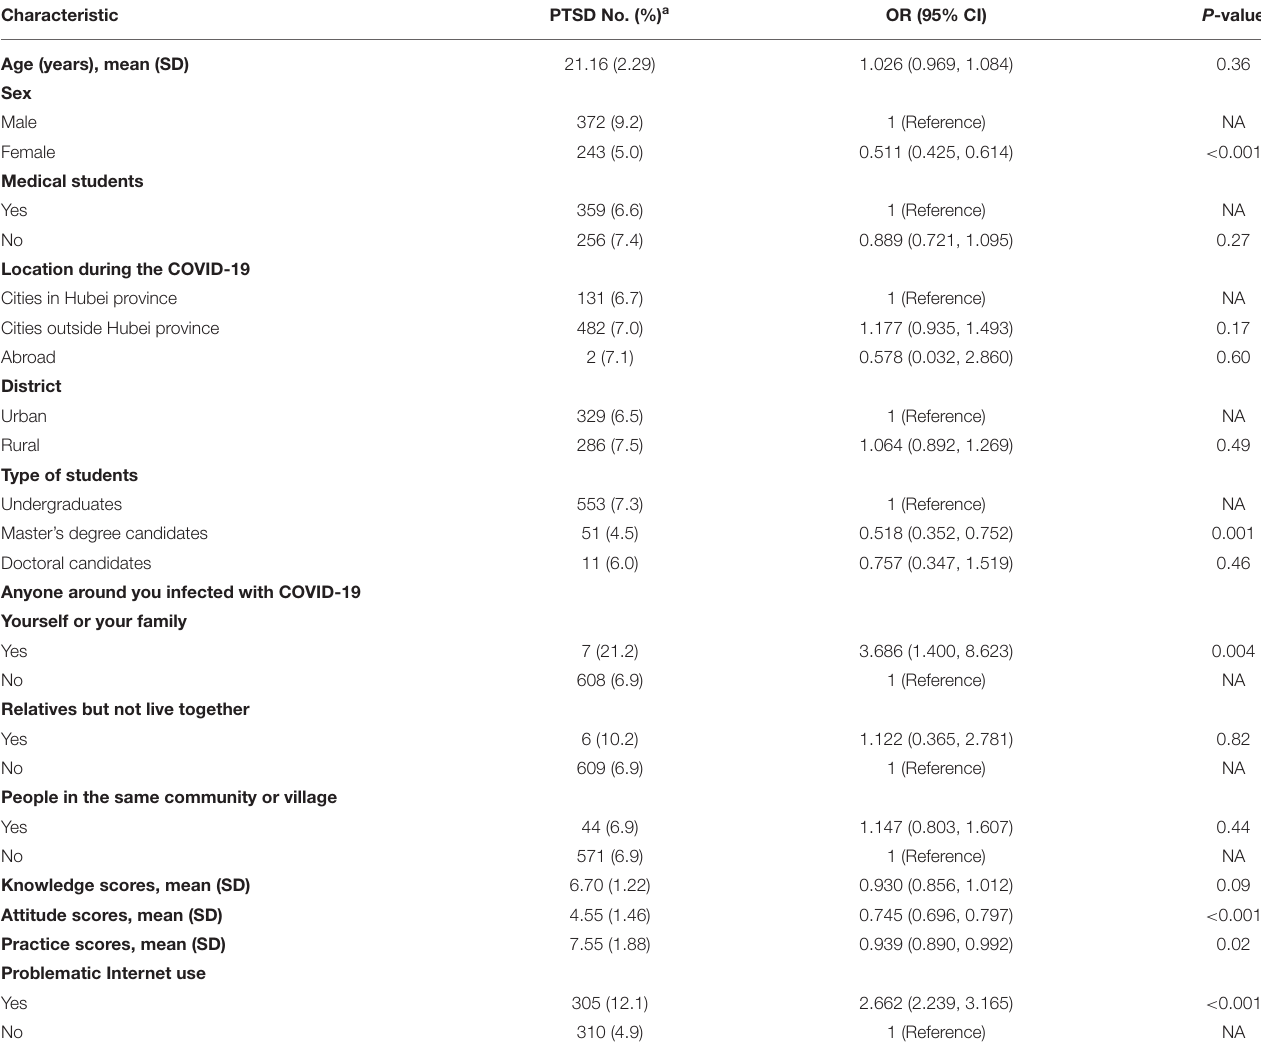
TABLE 2 | Characteristics of participants according to the posttraumatic stress disorder symptoms.